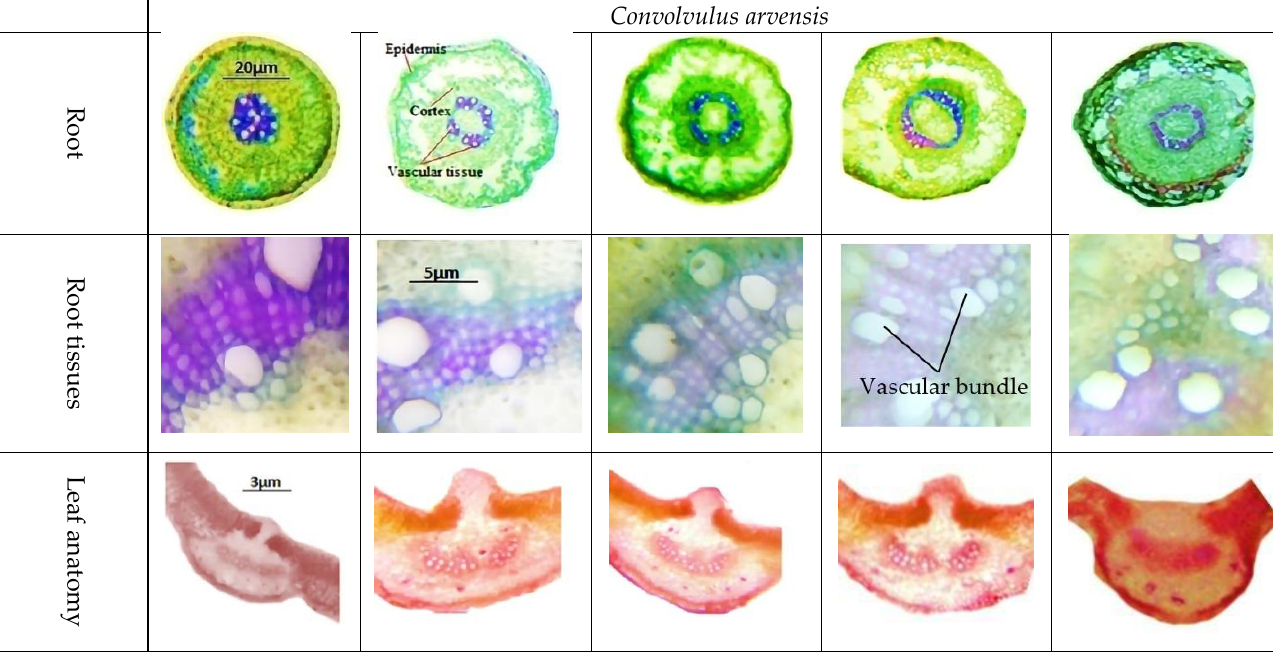
Figure 3. Root and leaf anatomy of A. tenuifolius and C. arvensis with applying different levels of shoot extract of T. portulacastrum and herbicide .